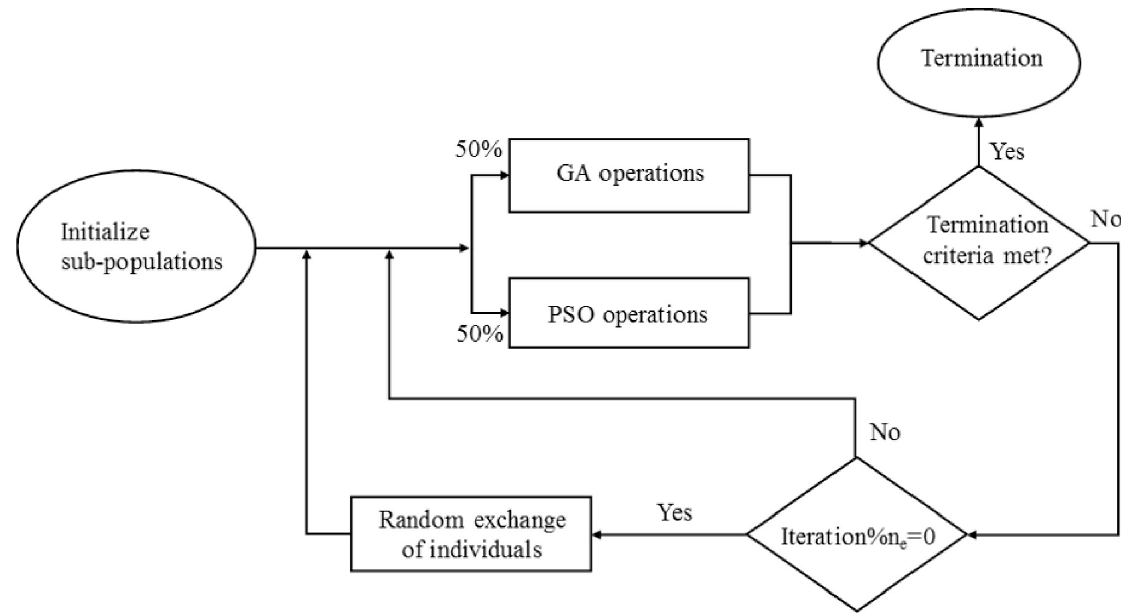
Fig 5. Flow chart for PGPHEA